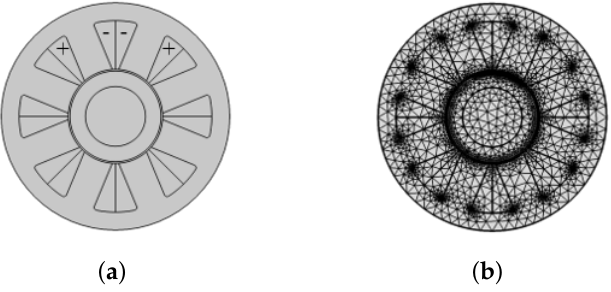
Figure 4. 2D finite element model: + and - refer to the domains where a positive and a negative current density J e is applied ( a ); meshed geometry of the system based on the semi-hard magnetic material ( b ).